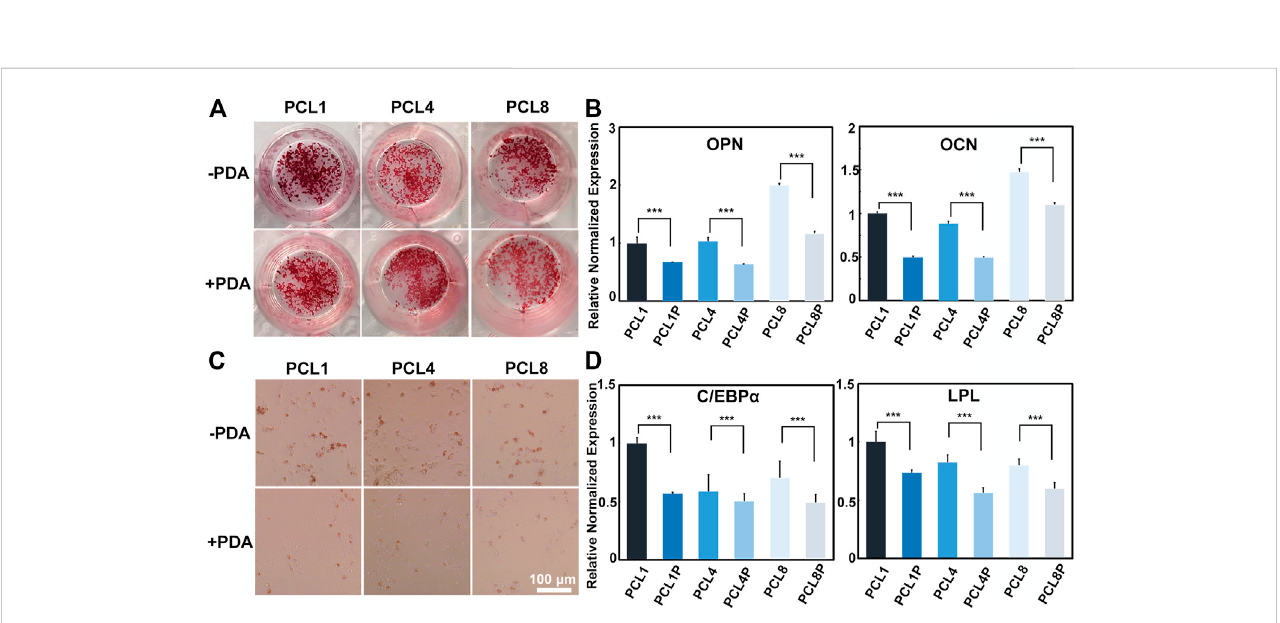
FIGURE 4 Induceddifferentiation ofBMMSCs after beingcultured ondifferentsubstrates. (A) AlizarinRed S stainingand (B) osteogenesis-relatedgene expressions ofthecellsafterosteogenicinductionfor14 days; (C) RedOilOstainingand (D) adipogenesis-relatedgeneexpressionsofthecellsafteradipogenicinduction for 7 days ( n =